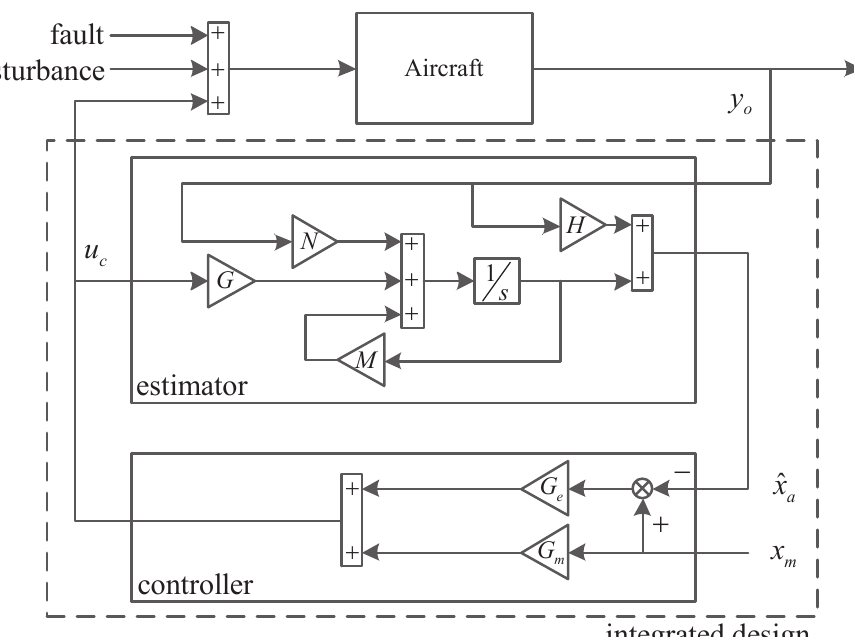
Figure 1. Block diagram of the